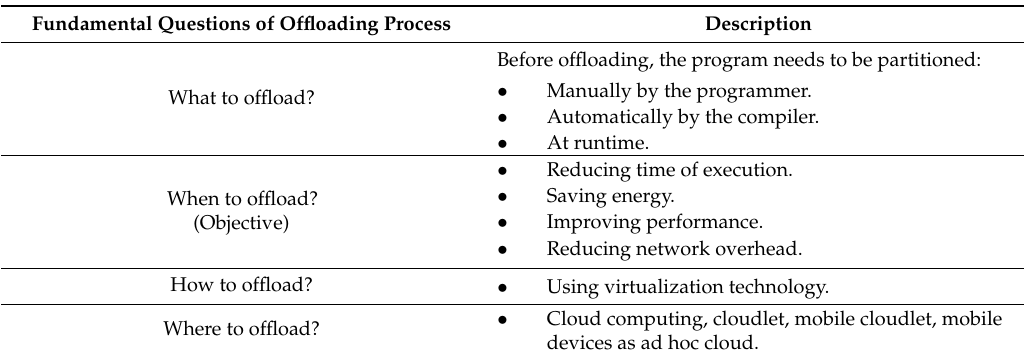
Table 1. Offloading process